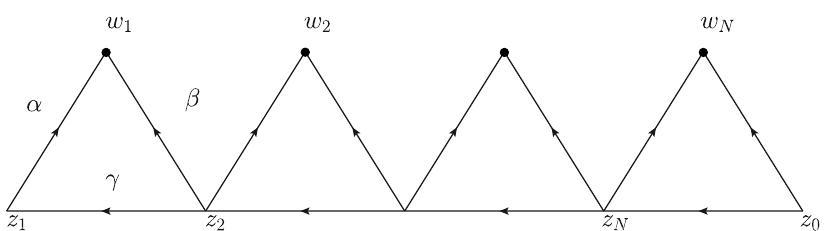
z 0 ). The arrow with index (cid:11) j